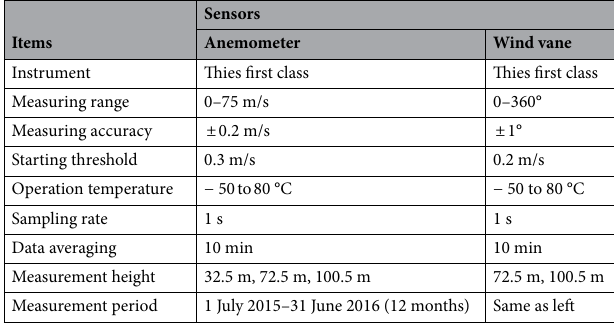
Table 1. The specification of wind sensors and measurement conditions.